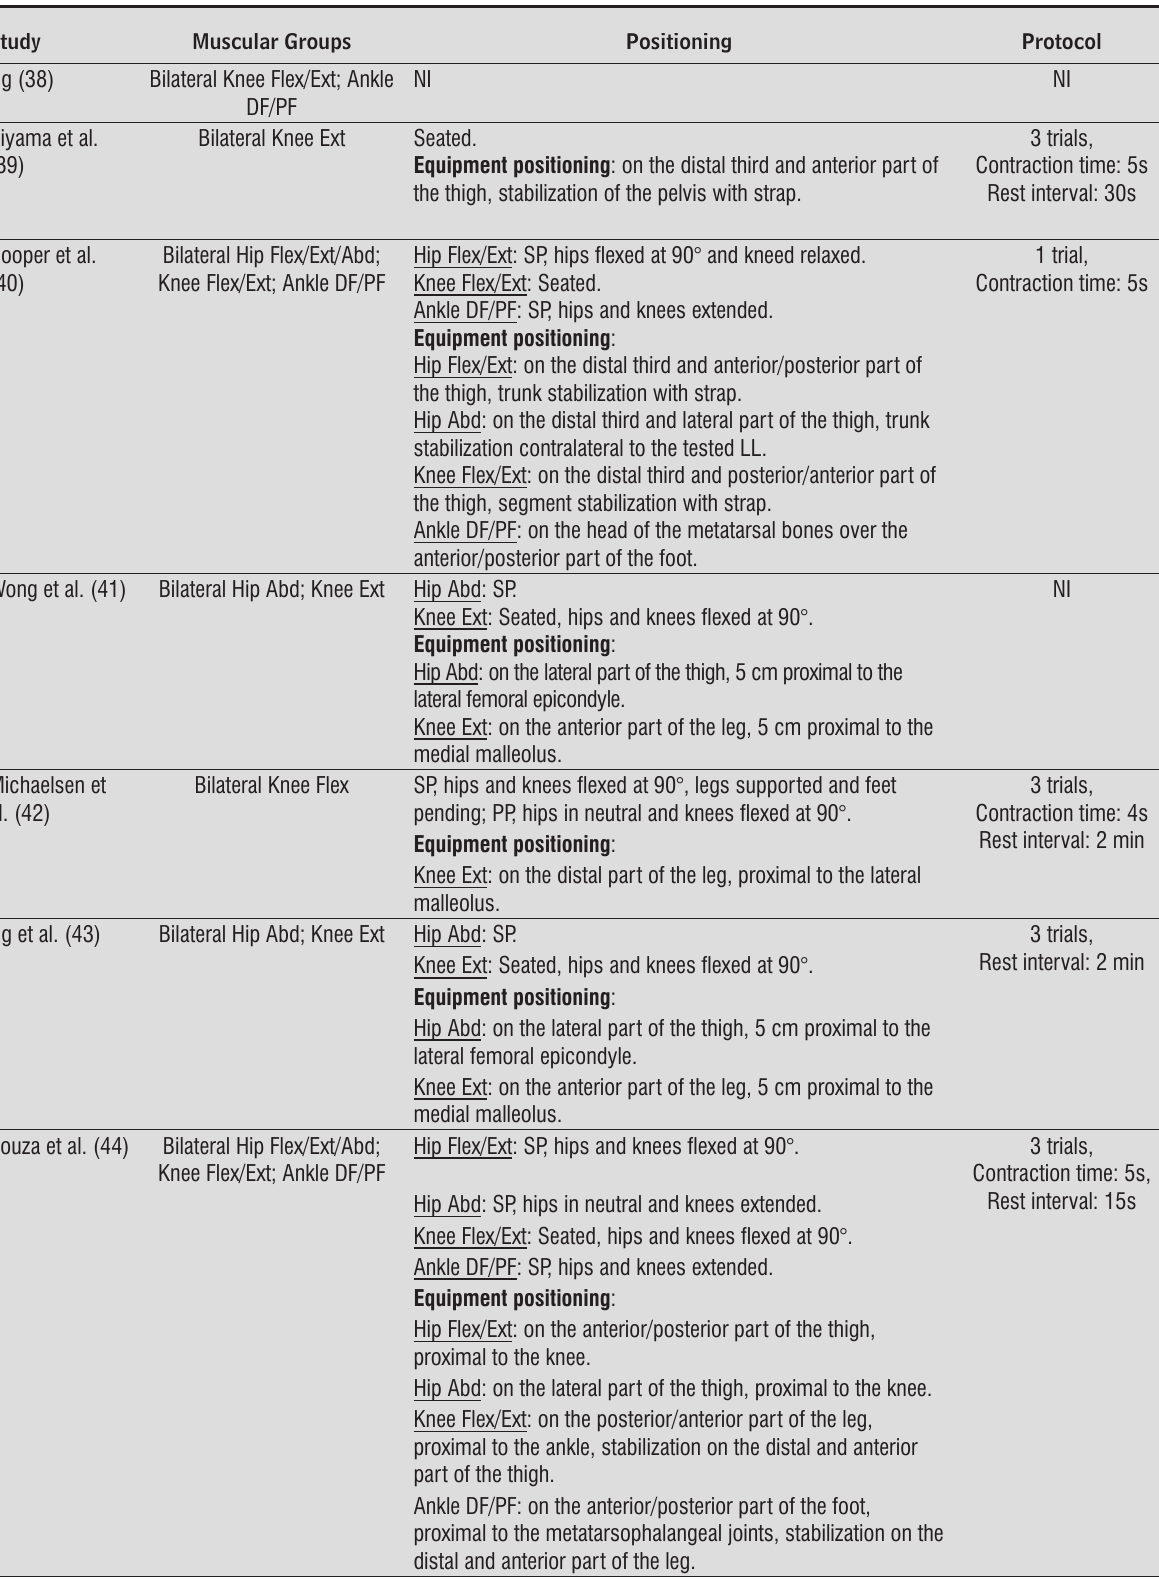
Table 2 - Data extraction of the 30 studies, which assessed the strength of the lower limb muscles with portable dynamometry in subjects with stroke and provided information regarding the positioning or the data